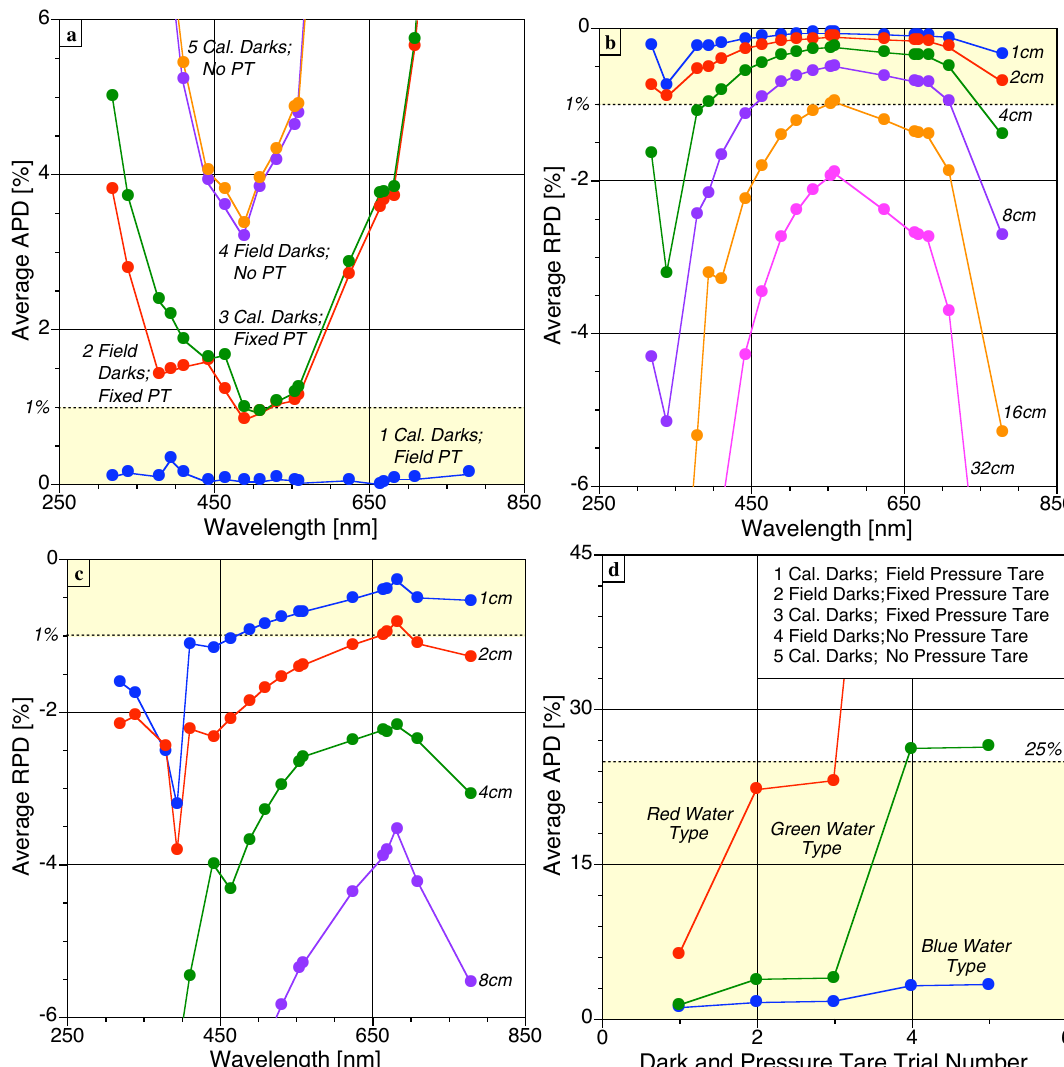
Fig. 5. The degradation in deriving data products from high-resolution C-OPS profiles as a result of incorrectly determining the dark offsets and the pressure tare. The degradation is expressed as the APD between the results obtained for the original processing parameters wherein field dark offsets and field pressure tares were used versus alternatives wherein field dark offsets, calibration darks, a fixed pressure tare, or no pressure tare were used (as shown using a unique color for each of five alternative combinations). The four panels correspond to the degradation analyses in L W (λ) for (a) the blue water type, (b) the green water type, and (c) the red water type, as well as to (d) the degradation in the derived chlorophyll a concentration (using the OC4v5 band ratio algorithm) as a function of the aforementioned water types and the five alternatives for dark offsets and pressure